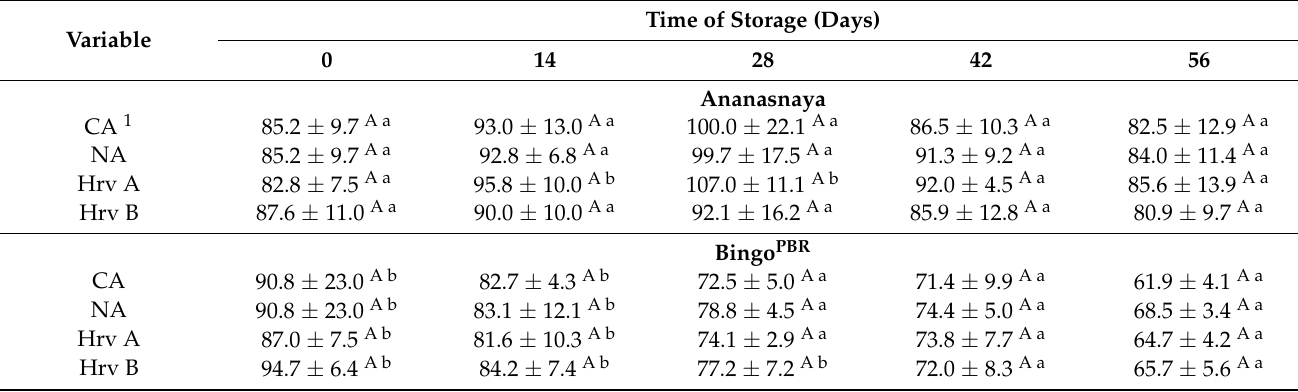
Table 9. Changes of total phenolic content [mg · 100 g − 1 f.w.] measured in ‘Ananasnaya’ and ‘Bingo’ PBR minikiwi fruit in postharvest period.